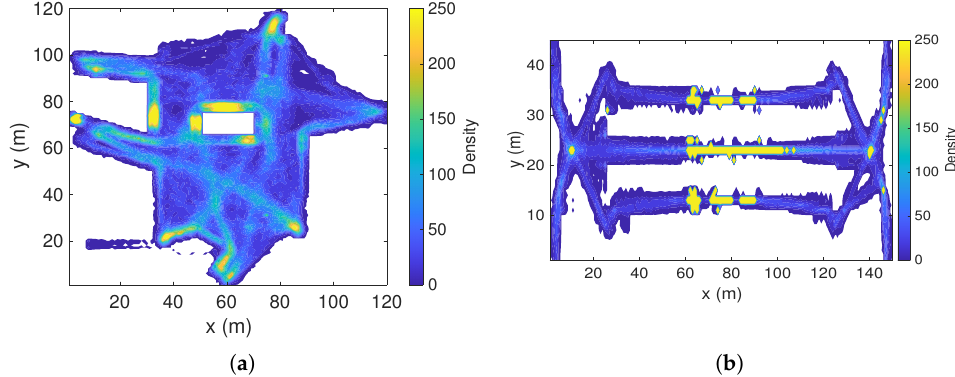
Figure 5. Density for m 2 of the PedSim generated scenarios. ( a ) Plaza scenario. Note that the white rectangle in the centre corresponds to a fountain (nonwalkable); ( b ) Station